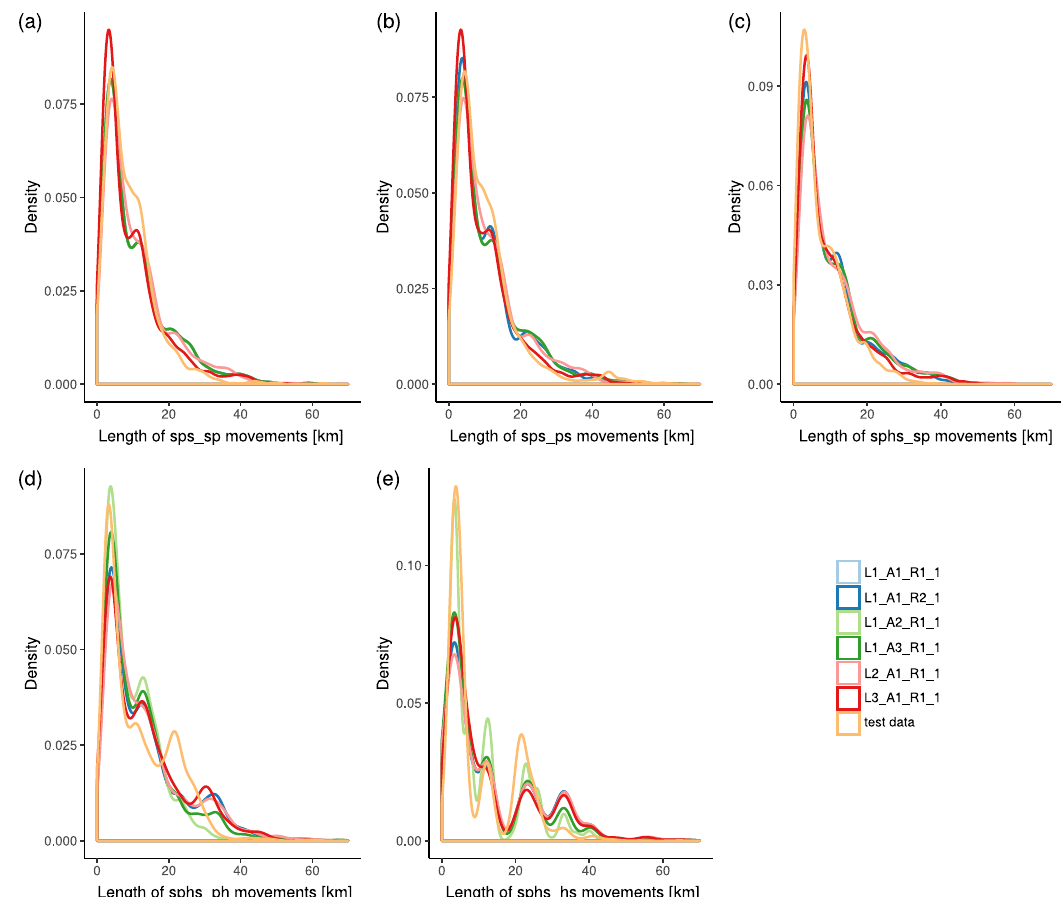
Figure 14. The probability density functions of movements’ lengths for “sps” and “sphs” trips. Each panel ( a – e ) corresponds to a different movement type of “sps” and “sphs” trips (indicated by the x-axis label). The default settings, i.e., L 1_ A 1_ R 1, are compared with test data, a linear model ( L 2), empirical probabilities ( L 3), the allocation of emergency cases to the closest hospital ( A 2), closest hospital-specific empirical probability distributions ( A 3), and the shortest path’s routing ( R